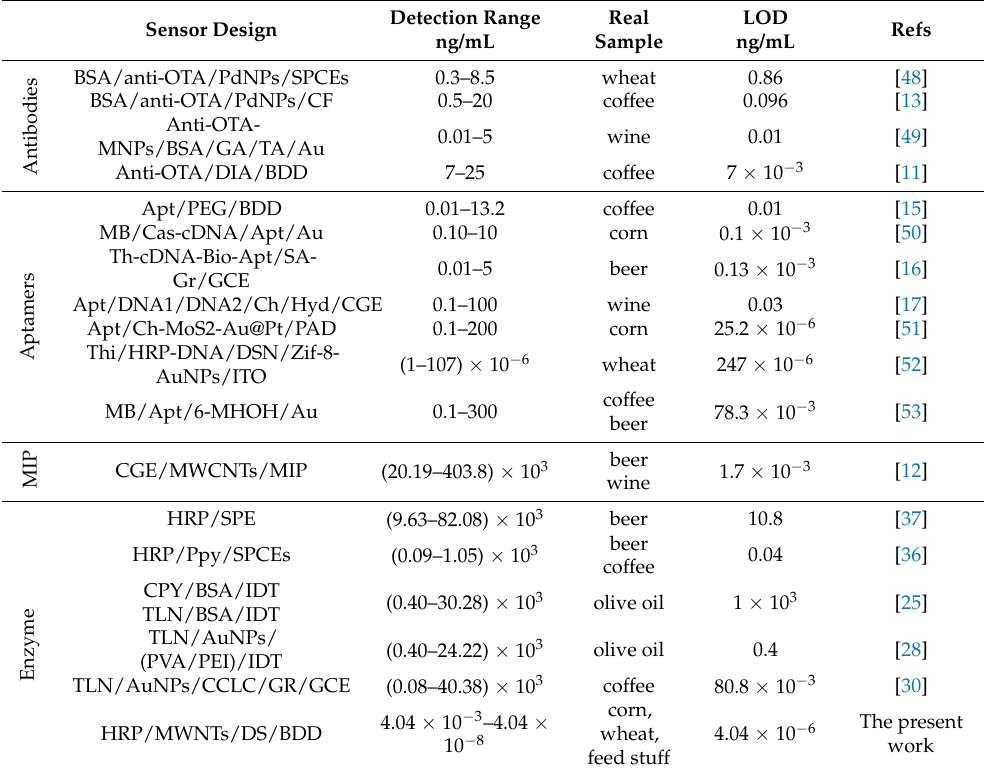
Table 1. Recently published sensors for OTA detection: immunosensors, aptasensors, MIP-based sensors, and enzymatic